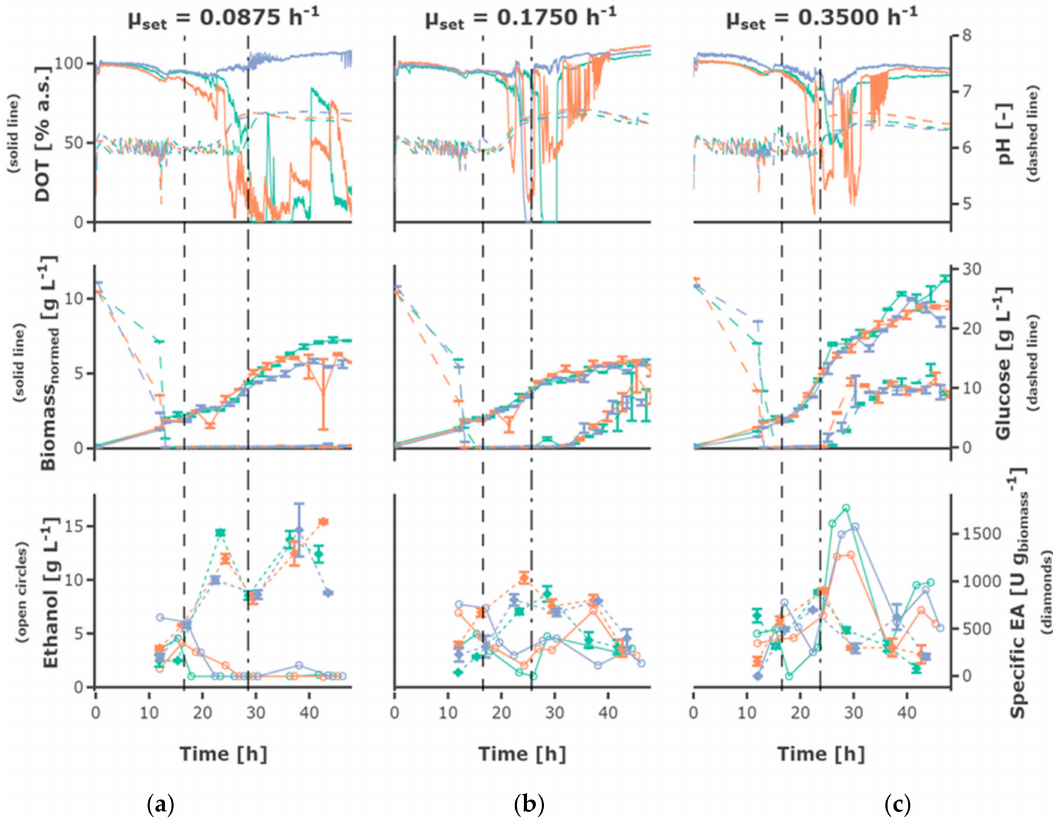
Figure 4. Measurement data is shown regarding the designs 1, 2, and 3—exponential feed with